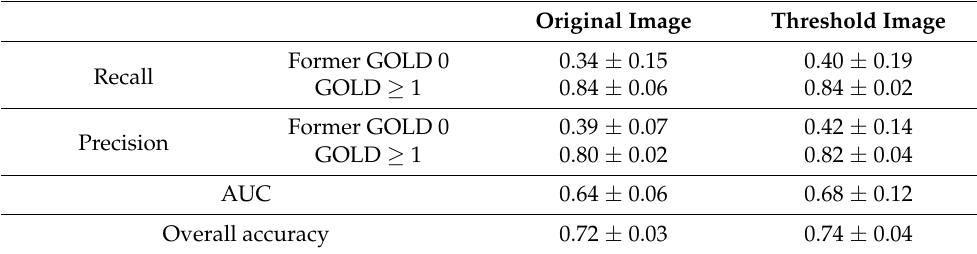
Table 4. Recall, precisions, AUC, and overall accuracy for two-class